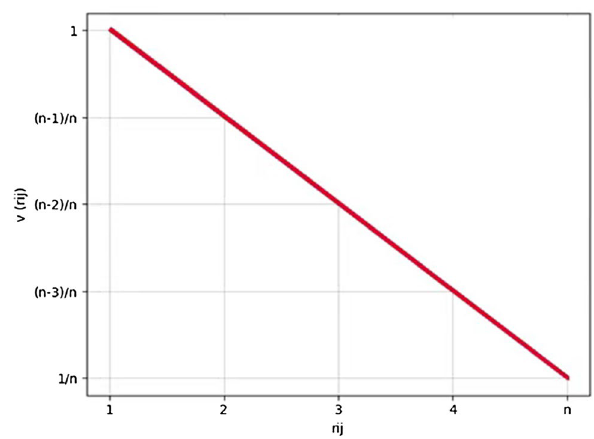
Fig. 1 Graphic illustration of the linear function of the degree of sat-